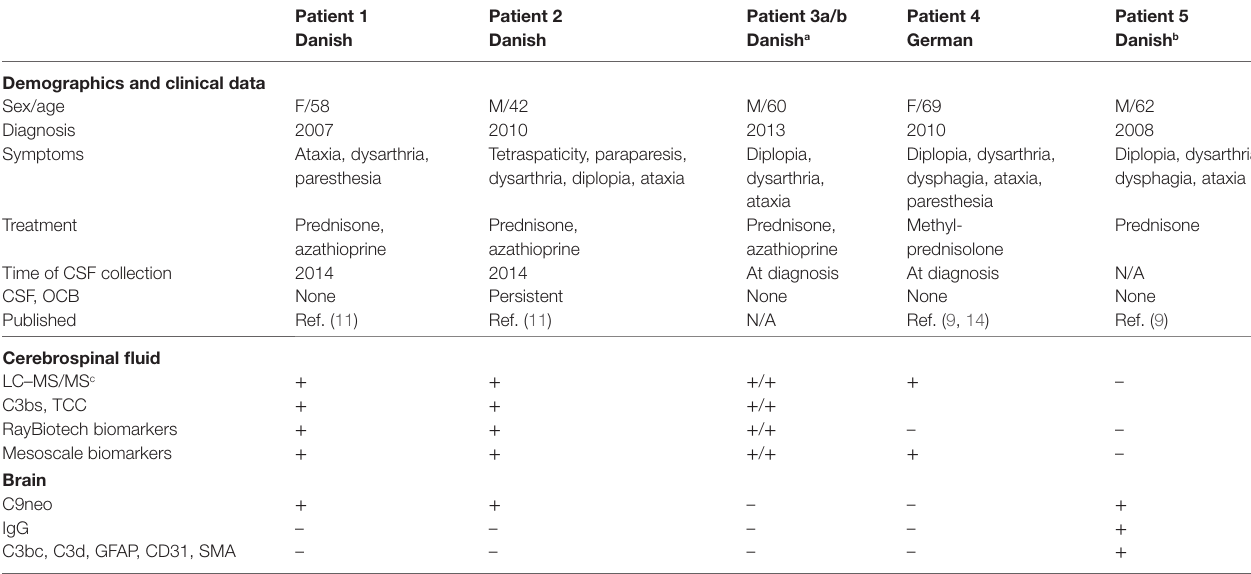
TaBle 1 | Demographics and methods used for the analysis of body fluids and tissues obtained from patients with chronic lymphocytic inflammation with pontine perivascular enhancement responsive to